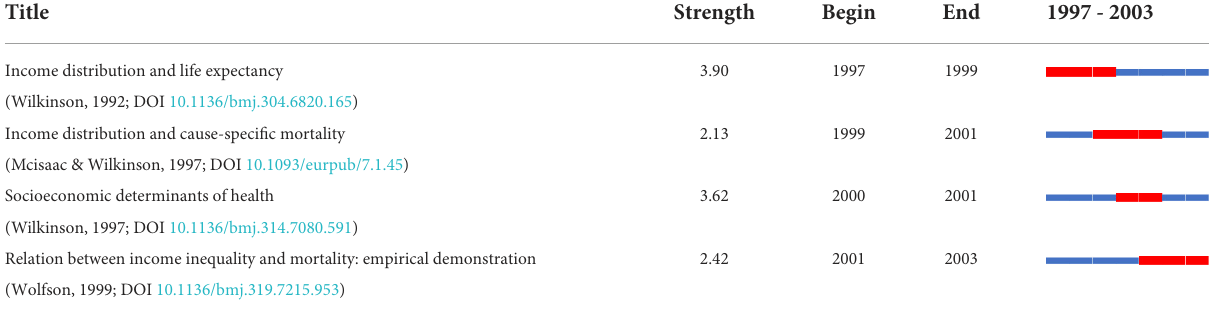
FIGURE8 Timeline visualization of clusters in 1997–2003.